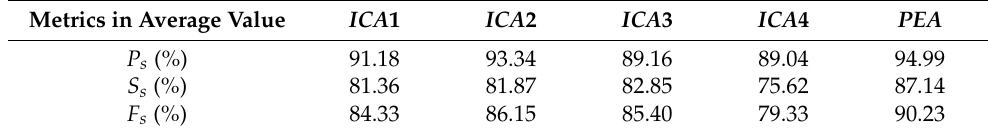
Table 3. Results comparison of LVNS-based NILM for individual